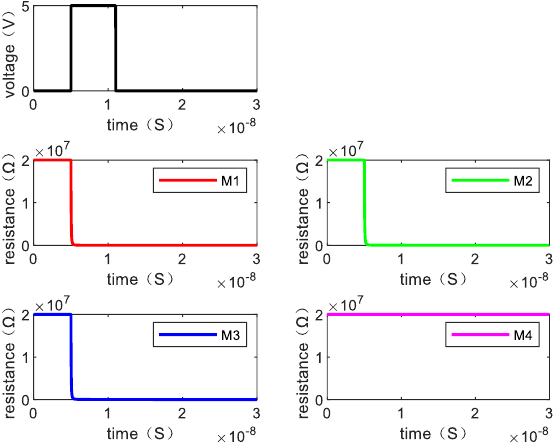
Figure 9. The resistance value of each memristor changes when writing